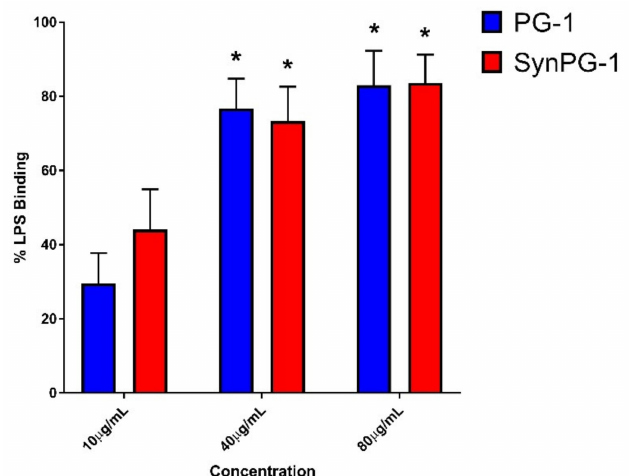
Figure 7. Comparison of the LPS binding ability between PG-1 and SynPG-1. The binding % was determined by measuring the ability to prevent LPS-induced activation of the LAL enzyme. Data represents the mean ± SEM of three independent experiments performed in duplicate. The asterisks represent a significant di ff erence from PG-1 at 10 µ g / mL at p < 0.05, as compared by two-way ANOVA with a post hoc Tukey test.